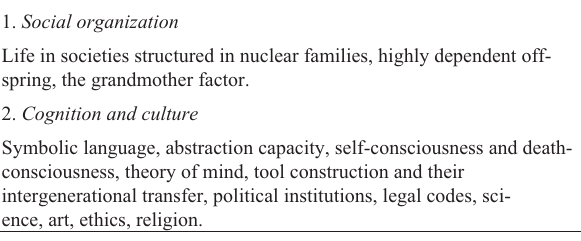
Table 2 - Selected typical Homo sapiens characteristics.